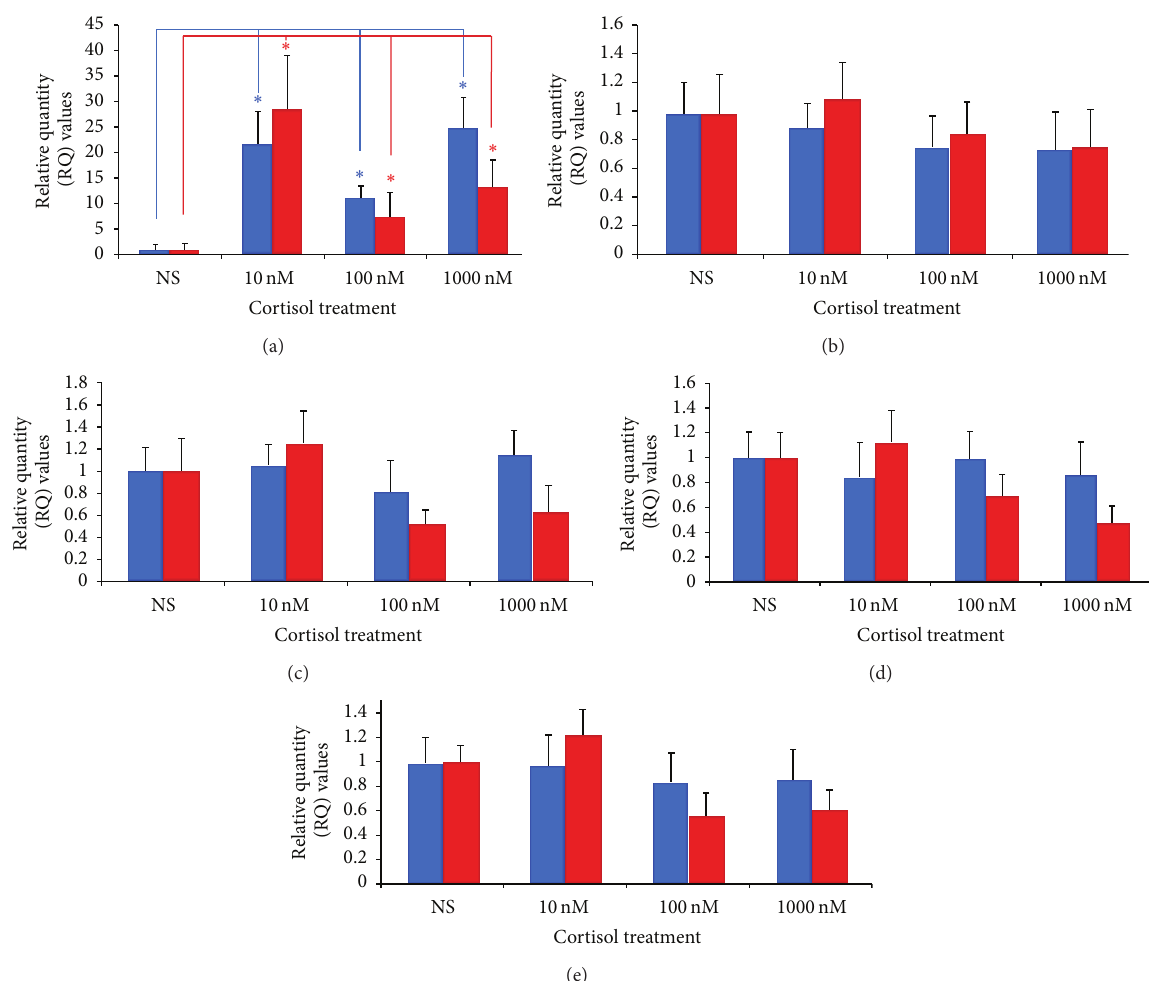
Figure 4: Effects of cortisol on the expression of GAS5 (a), GR 𝛼 (b), GR 𝛽 (c), GR 𝛾 (d), and GR-P (e) in JEG-3 (red) and BeWo (blue) placental cell lines. NS: no supplement, ∗ 𝑃 < 0.05